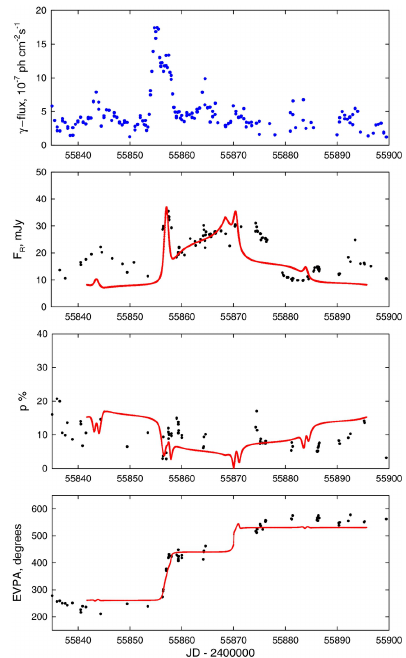
Figure 19. Fits to the optical light curve, polarization degree, and PA of S5 0716+714 in October 2011, using a model of a shock in a helical jet. From [126]. Reproduced with permission from the American Astronomical Society